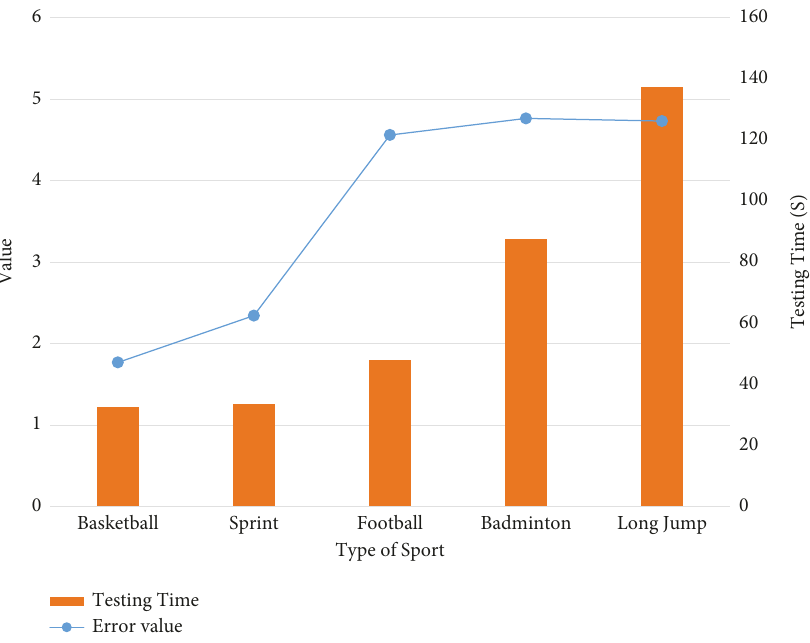
Figure 9: Comparison of error value and test